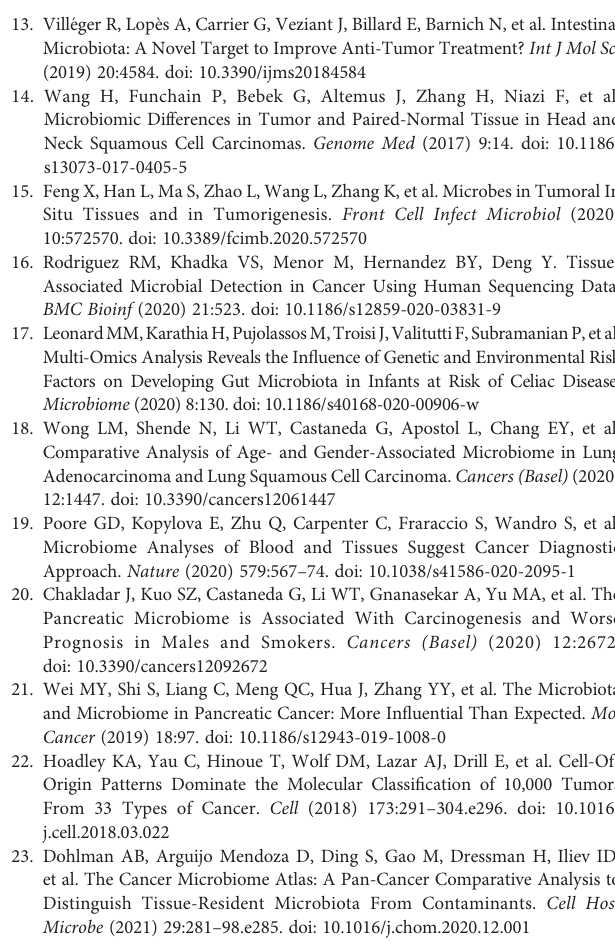
Supplementary Figure 1 | PLS-DA plots based on microbial pro fi le of tumor and normal samples from the same organ. PLS-DA plots at phylum, order, and genus levels of tumor and normal samples from ESCA (A) , STAD (B) , COAD (C) , and READ (D)